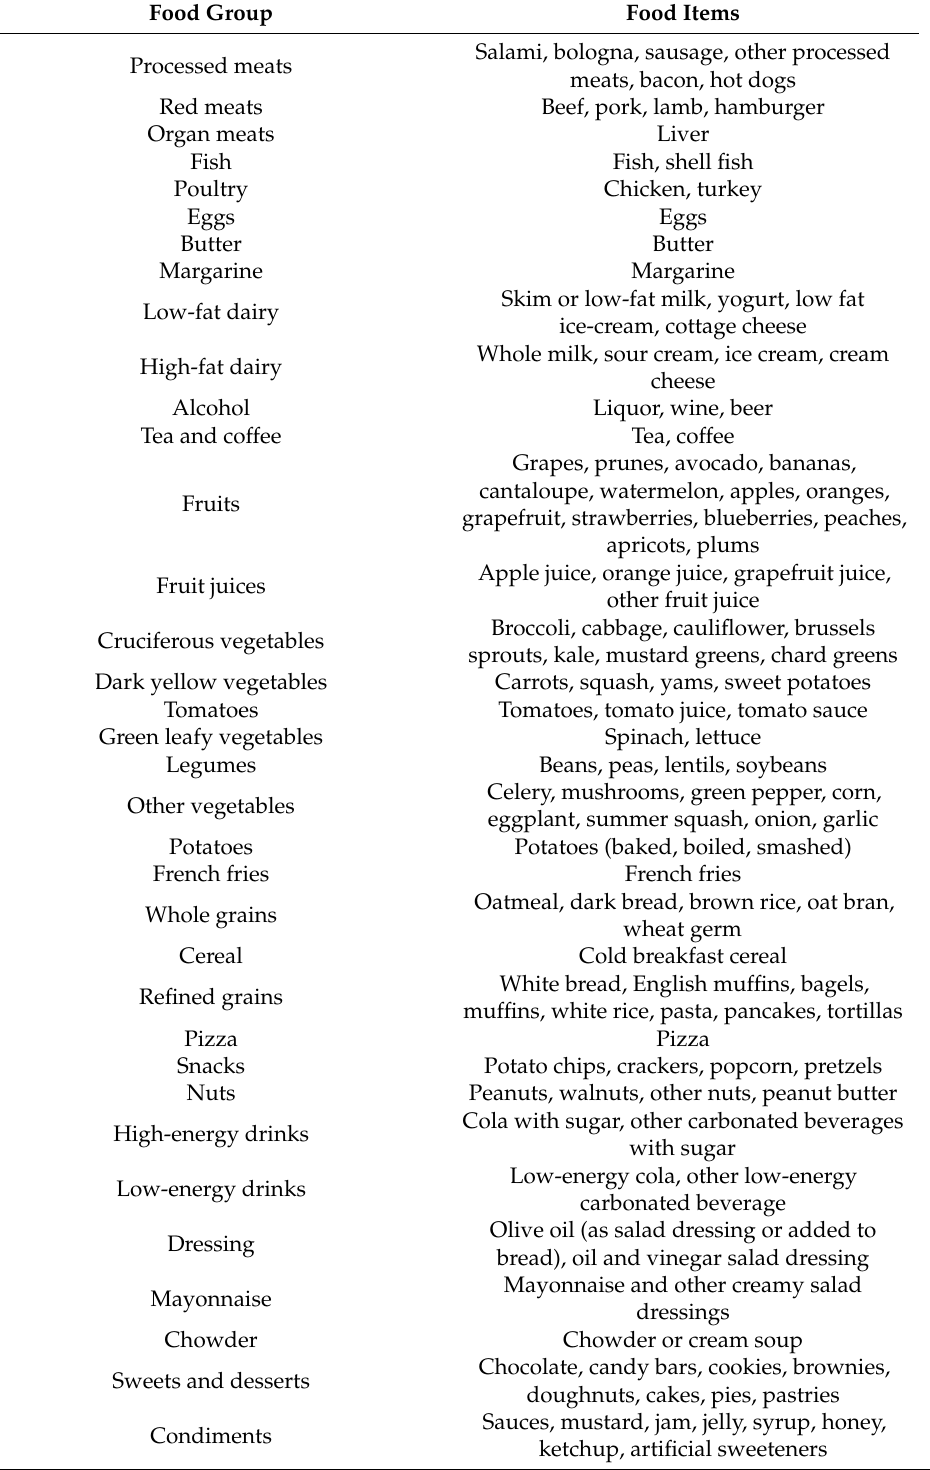
Table 1. Food groupings used in the dietary pattern